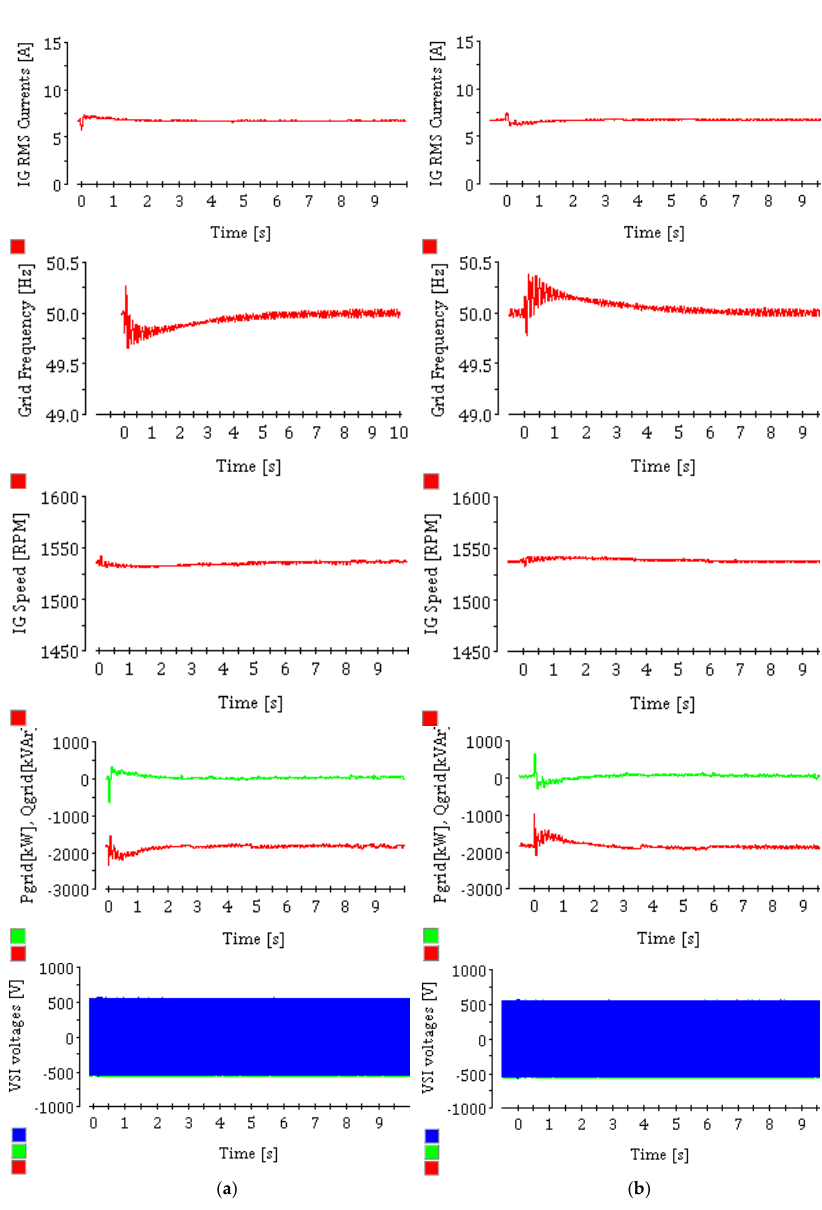
Figure 10. Experimental results for case 2: ( a ) MG load increase and ( b ) MG load decrease. In the experiments, before the synchronization, the IG was delivering 2 kW and had a very small local load; this particular situation was chosen as the most difficult scenario because it involved the maximum power transfer between the IG system and the MG. The influence of the